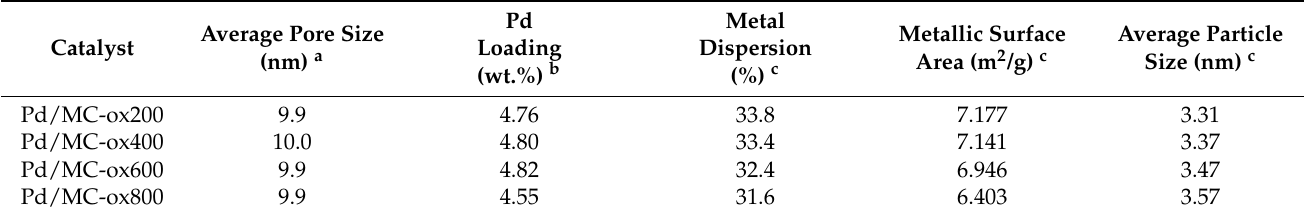
Table 4. Characteristics of the Pd/MC-ox catalysts.